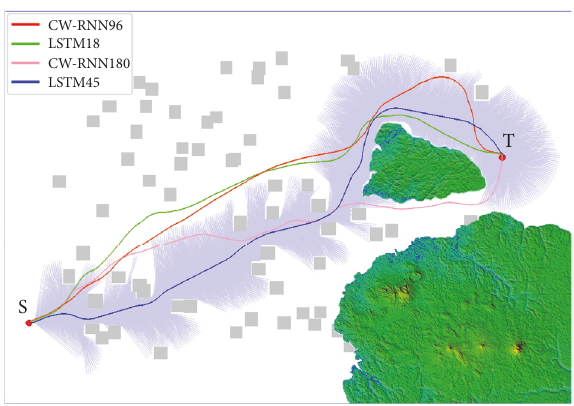
Figure 10: Online planning results of four obstacle avoidance algorithms of UUV in simulation test case 2.